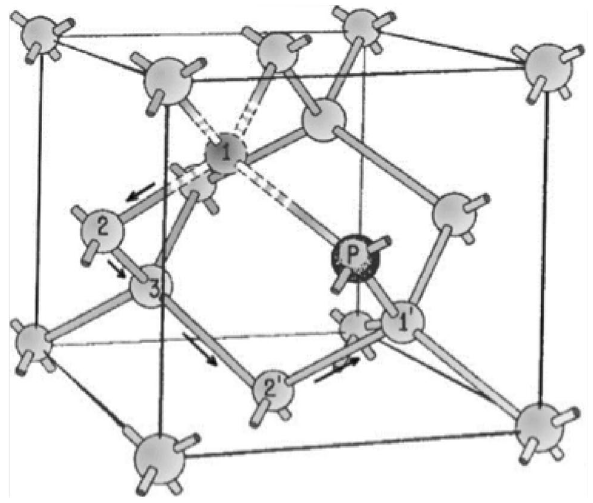
Figure 1. The silicon lattice containing a Phosphorus-Vacancy defect. The vacancy taking the place of one of Si-atom closest to P atom (position 1) can move through the lattice away from the P atom (position 3) and approach again close to P atom (position 1 ′ ) 23